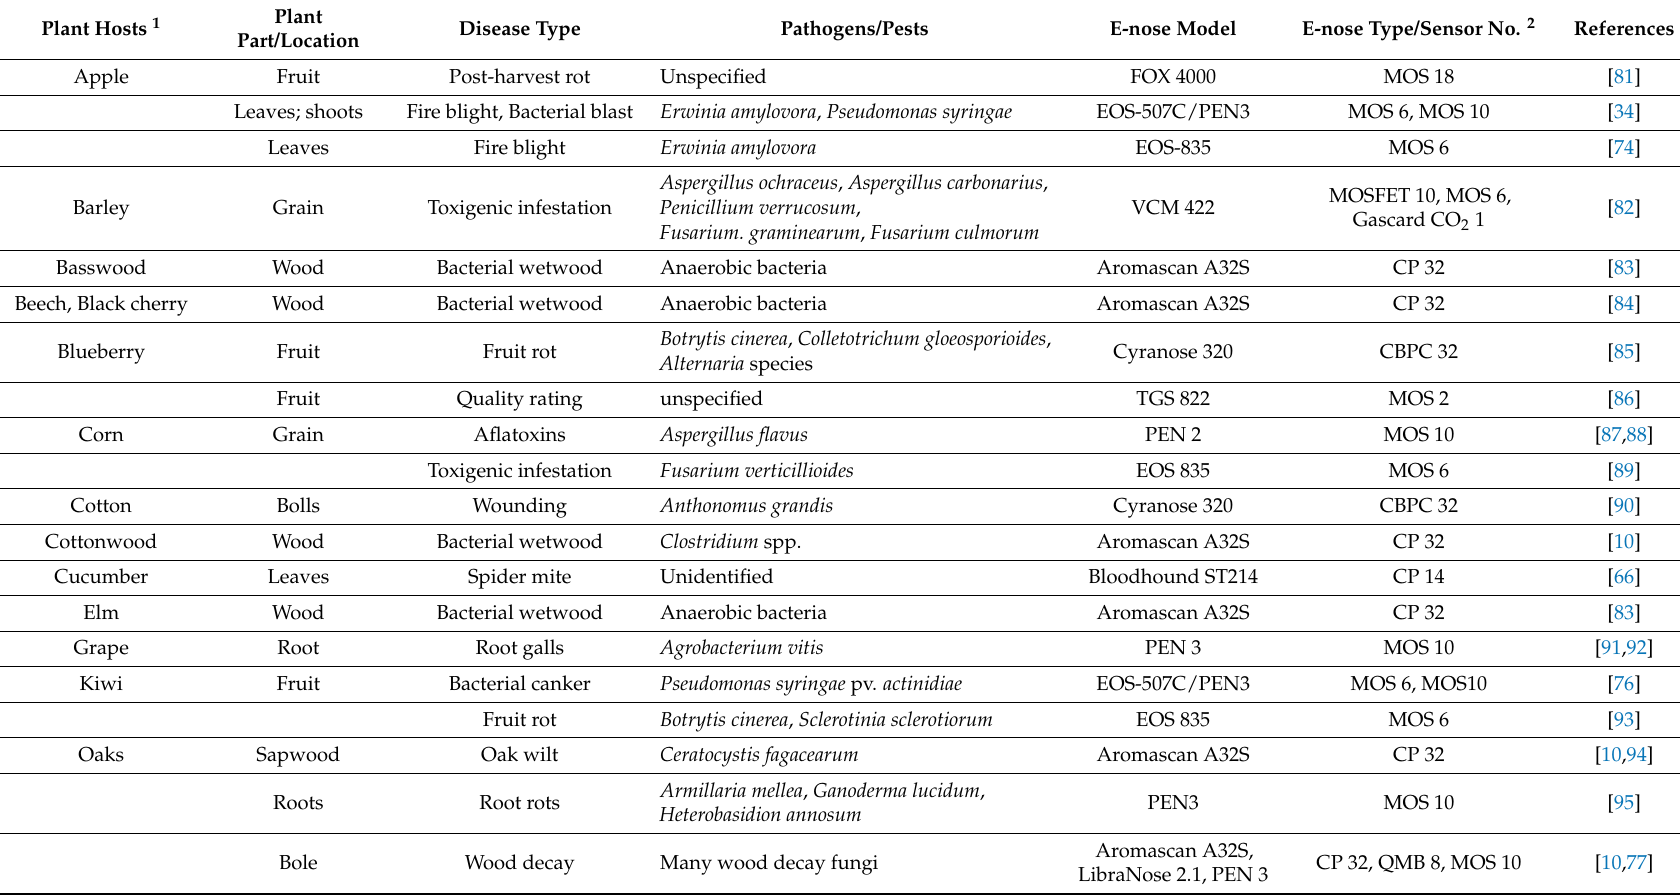
Table 2. Applications of electronic-nose devices to detect plant diseases associated with specific host-pathogen and pest combinations. Plant Hosts